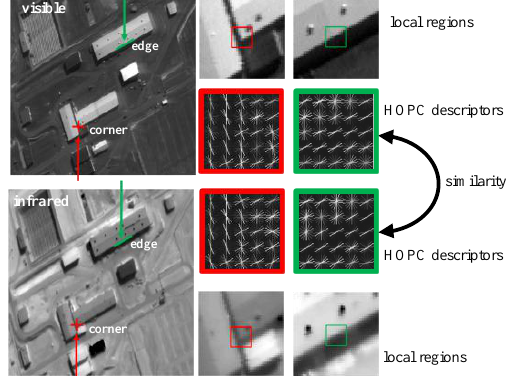
Figure 7. HOPC descriptors of the visible and infrared images in the corner and edge regions